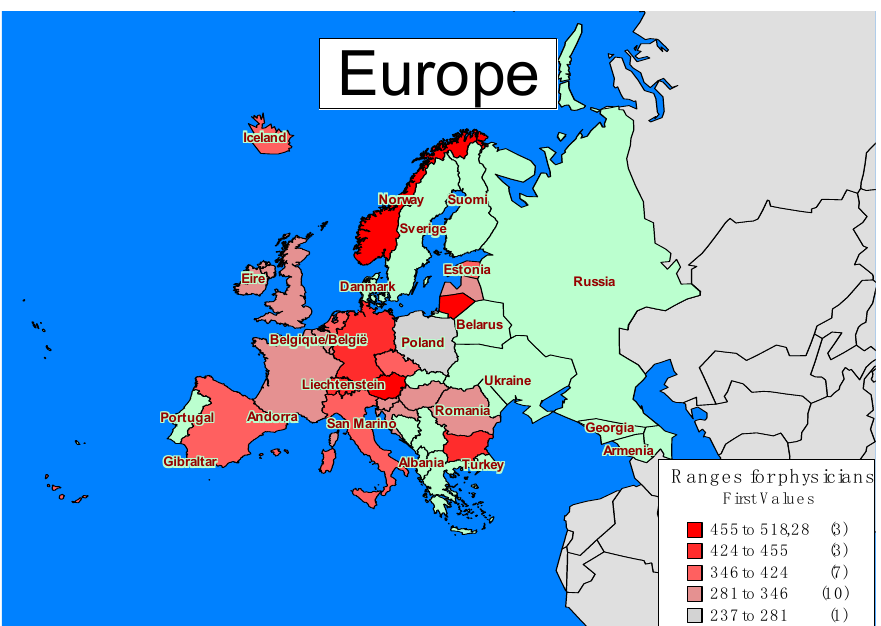
Figure 1. Physicians available to 100,000 inhabitants, Europe, 2017.